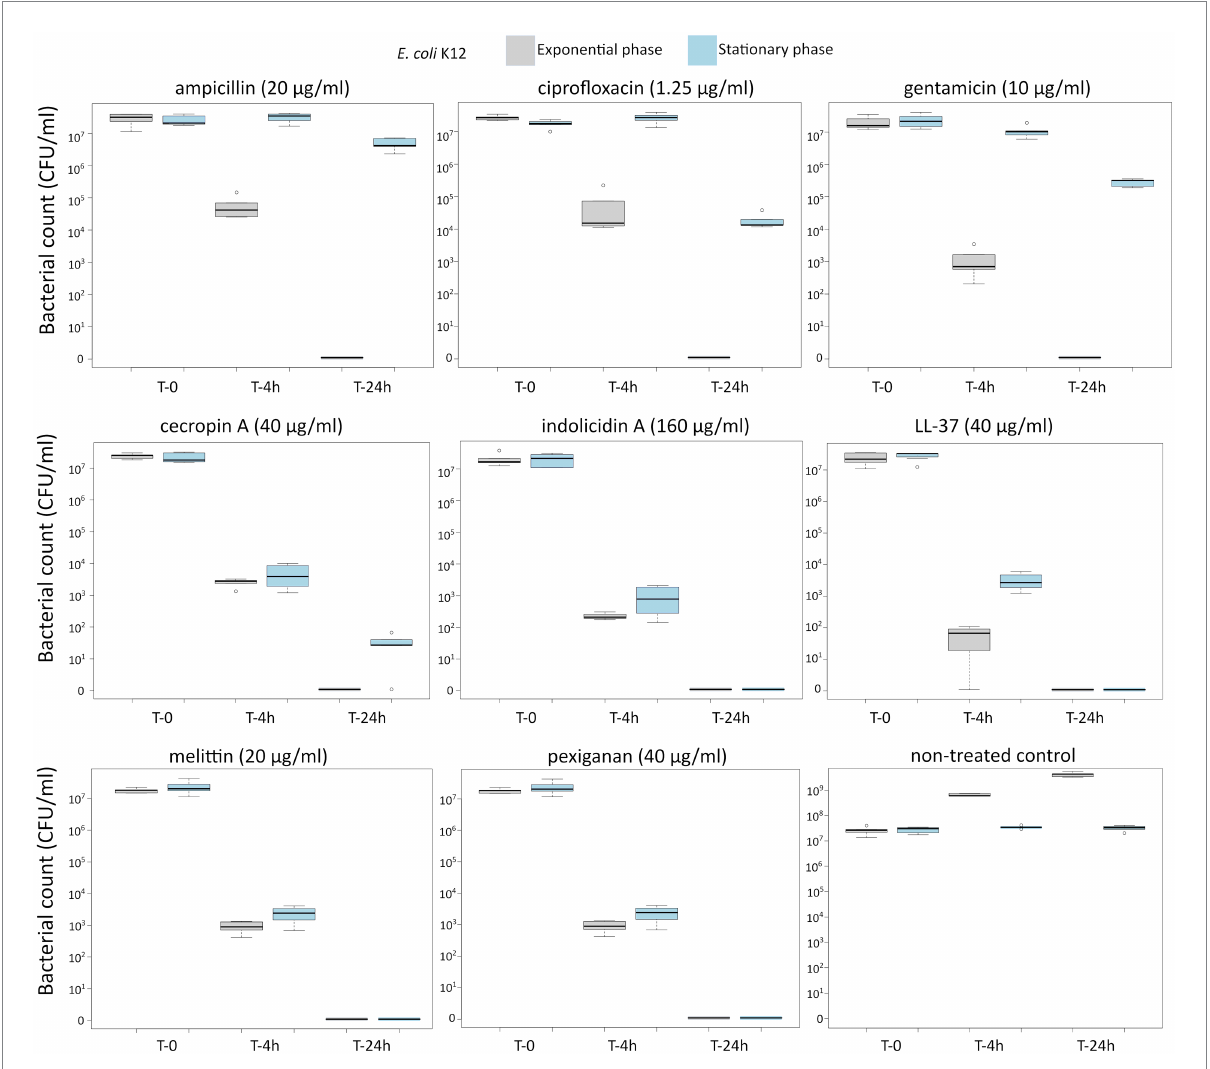
FIGURE 1 Killing of Escherichia coli K12 at 10× MIC for five antimicrobial peptides and three different antibiotics. The gray boxes indicate bacteria growing exponentially while the blue ones denote bacteria treated in the stationary phase in spent medium prepared as described in the Materials and methods